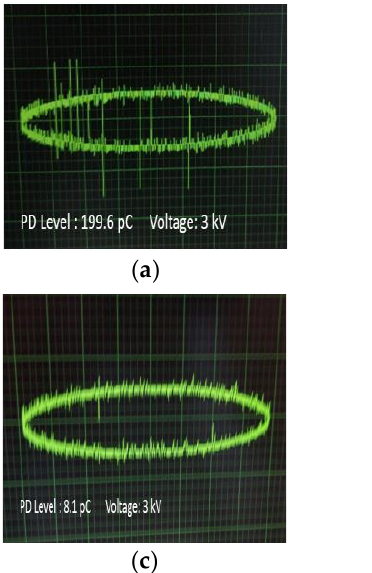
Figure 10. Waveforms of PD pulses at 3 kV AC voltage for the insulating paper impregnated with: ( a ) Net; ( b ) NF1; ( c ) NF2; ( d ) NF3 samples.